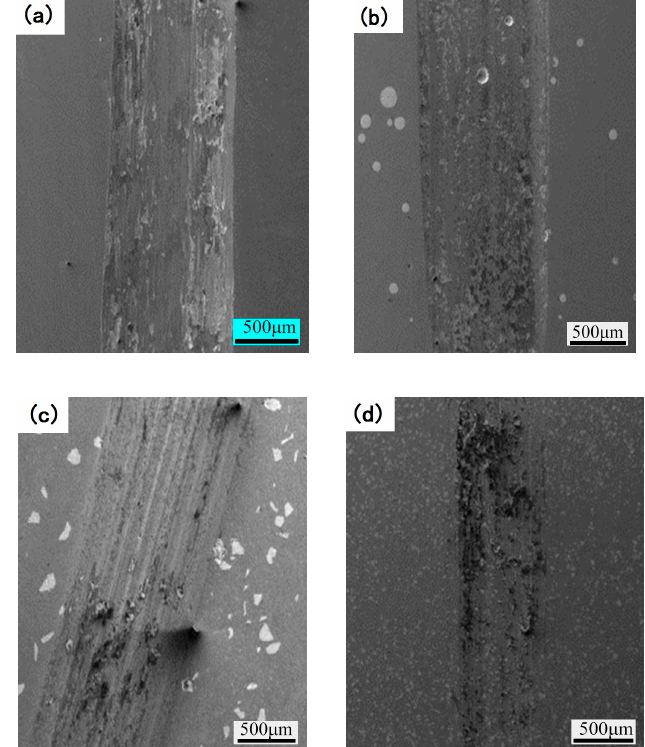
Figure 6. SEM images of the worn surfaces of different coatings. ( a ) Ni60, ( b ) Ni60-spherical WC, ( c ) Ni60-shaped WC, ( d ) Ni60-flocculent WC.